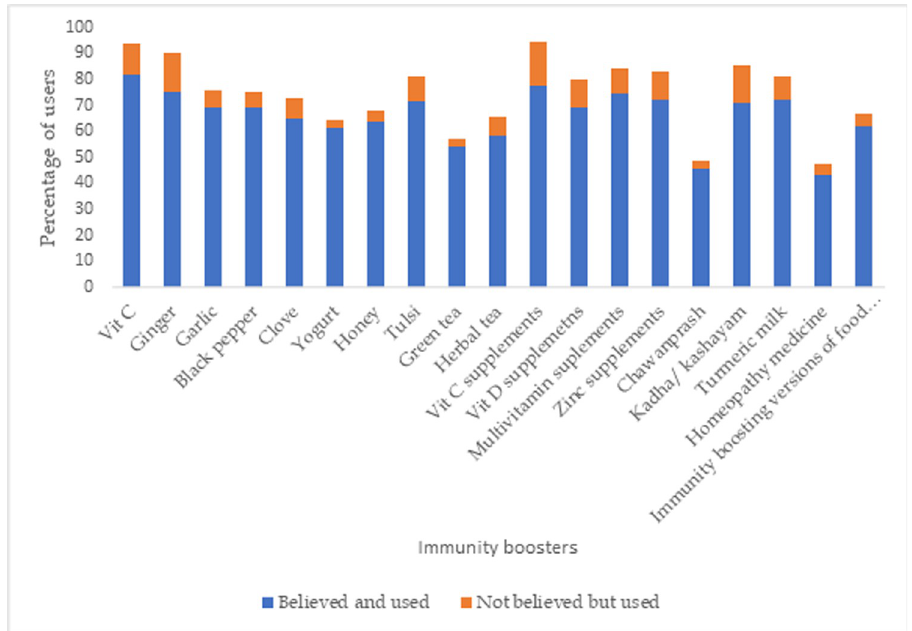
Fig 3. The perception of the respondents who reported to use each of these ‘immunity boosters’ about their ability to prevent COVID-19 infection.